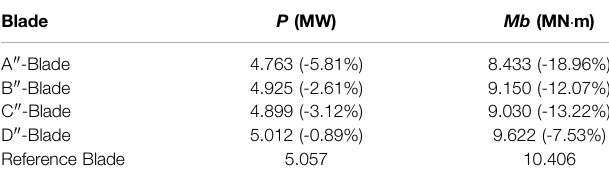
TABLE 4 | The aerodynamic characteristics of the rotor with the variation of only the twist